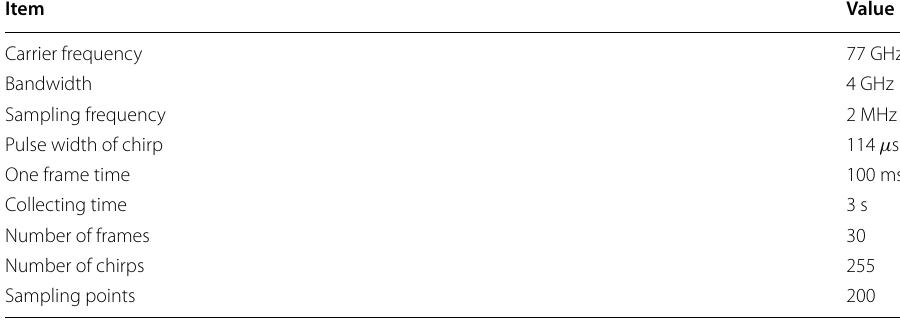
Table 3 Parameters setting for eye blink detection